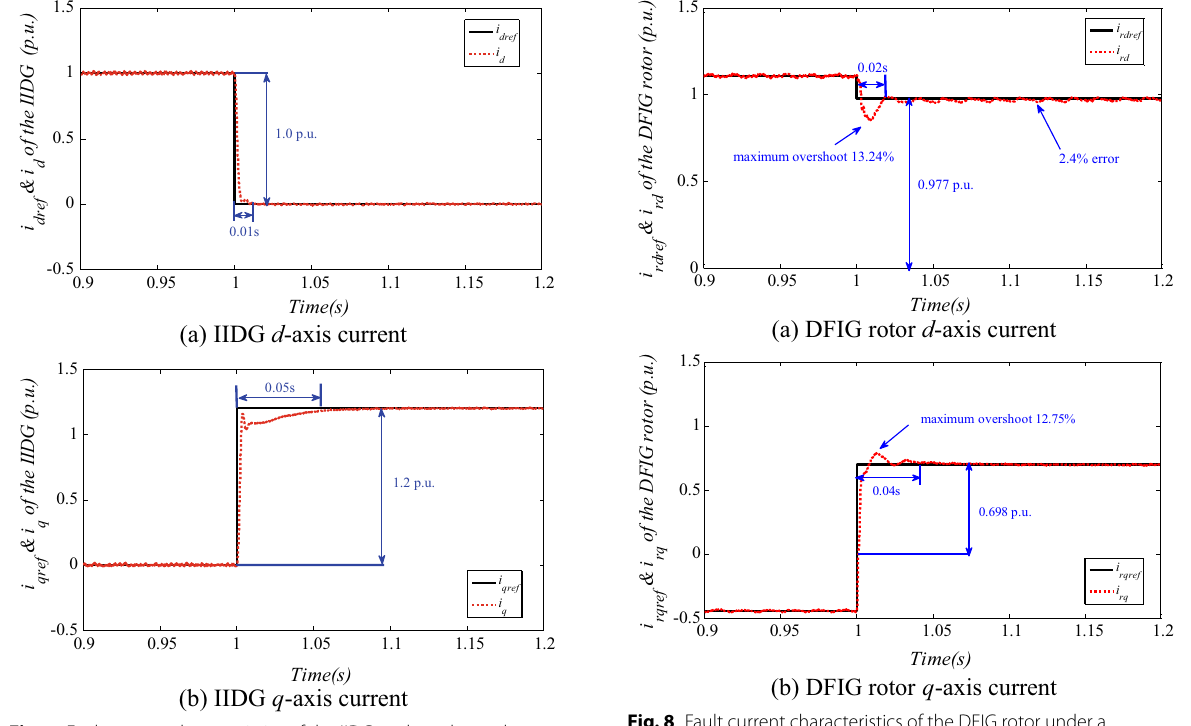
Fig. 7 Fault current characteristics of the IIDG under a three‑phase fault. a IIDG d ‑axis current. b IIDG q ‑axis current